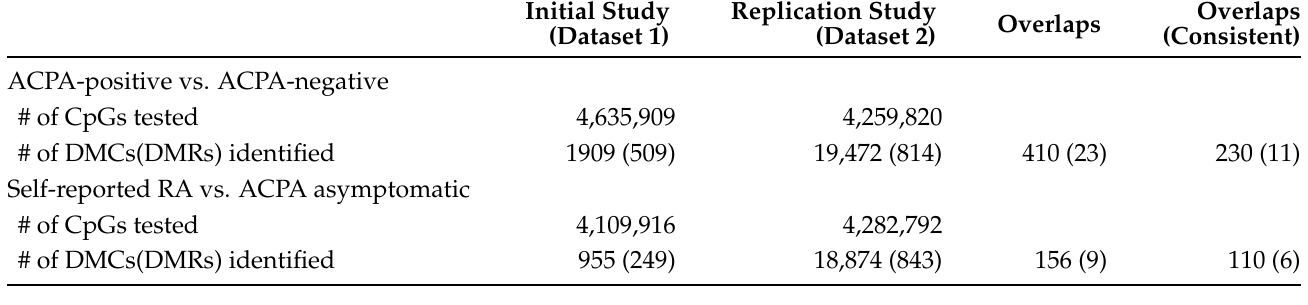
Table 4. The number of DMCs (DMRs) identified in the initial and this replication study, and overlap in captured sites.